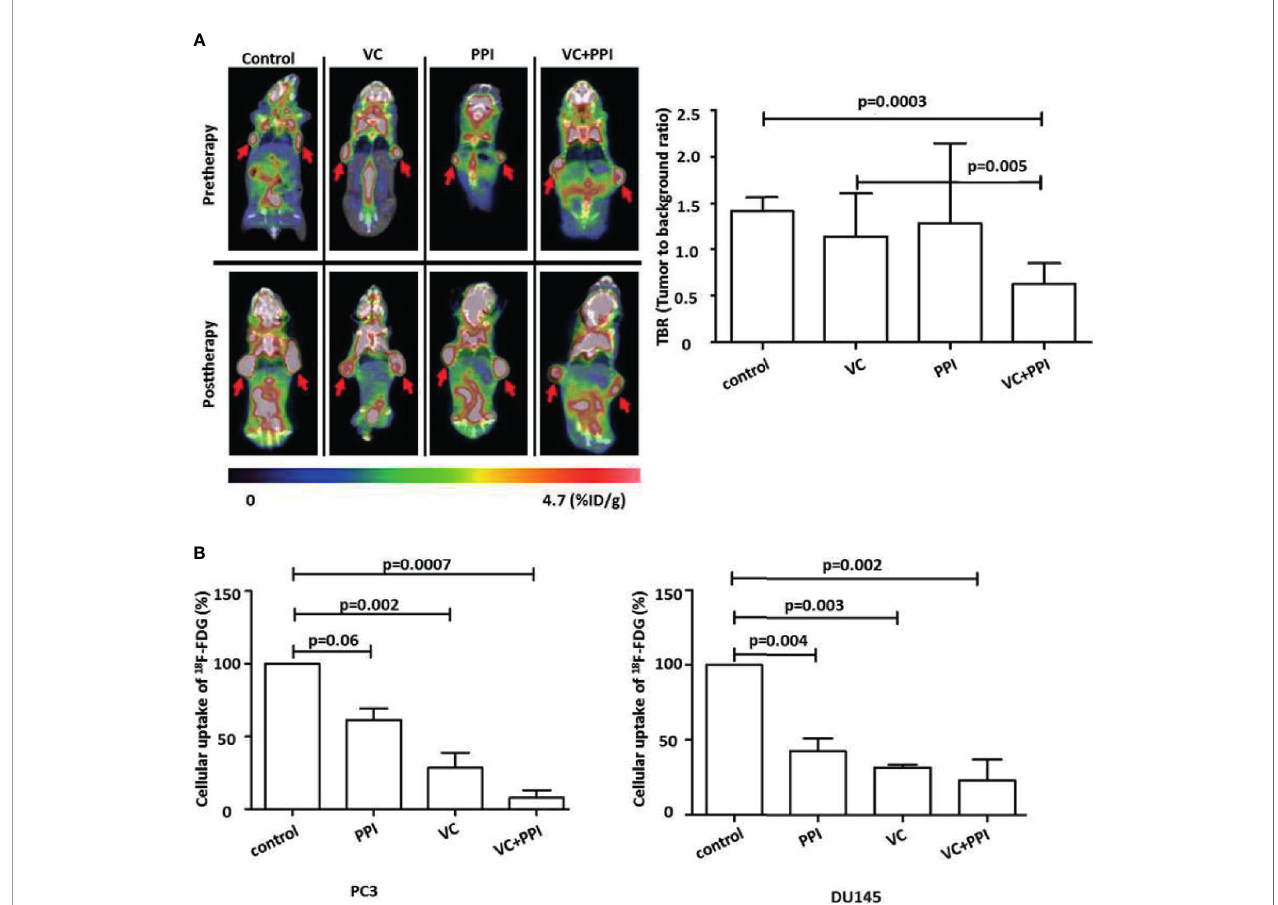
FIGURE 6 | Functional FDG-PET/CT imaging showing that pantoprazole enhances the anticancer effect of vitamin C in vivo . (A) Left panel: representative PET/CT scans showing the changes in tumor uptake of 18 F-FDG (red arrows). 18 F-FDG-PET/CT scans were carried out before (Pretherapy, day 0) and 14 days after the initiation of treatment (Posttherapy, day 14). The red arrows indicate the sites of subcutaneous injection of PC3 tumor cells and the accumulation of 18 F-FDG. Right panel: uptake of 18 F-FDG in tumor tissue (tumor to background ratio [TBR]) in control mice and mice treated with vitamin C (VC), pantoprazole (PPI) or both (VC+PPI). The TBR was calculated 14 days after the initiation of treatment and served as an indicator of tracer uptake. The mean TBR as detected via 18 F-FDG-PET/ CT was signi fi cantly reduced following combined treatment (VC + PPI) compared with control treatment (p = 0.0003), indicating a signi fi cant reduction in tumor volume. Moreover, the reduction in TBR after combined VC + PPI treatment compared to treatment with vitamin C only was also signi fi cant (p = 0.005). (B) PC3 and DU145 prostate cancer cells were incubated with 18 F-FDG for 30 min at 5% CO 2 and 37°C. After washing twice with cold PBS, the cells were detached with trypsin, and cell-associated 18 Fradioactivity was quanti fi ed with a g -counter. 18 Fradioactivity is expressed as percent uptake per cell relative to the uptake of untreated controls. In both prostate cancer cell lines (PC3 and DU145), the combination treatment signi fi cantly reduced cellular uptake of 18 F-FDG (p=0.0007 in PC3 and p=0.002 in DU145, compared to control, respectively. VC: treatment with vitamin C (4 mM); PPI: treatment with pantoprazole (100 µM); VC + PPI: combined treatment with vitamin C (4 mM) and pantoprazole (100 µM). The bars represent the mean and SD of the mean of n ≥